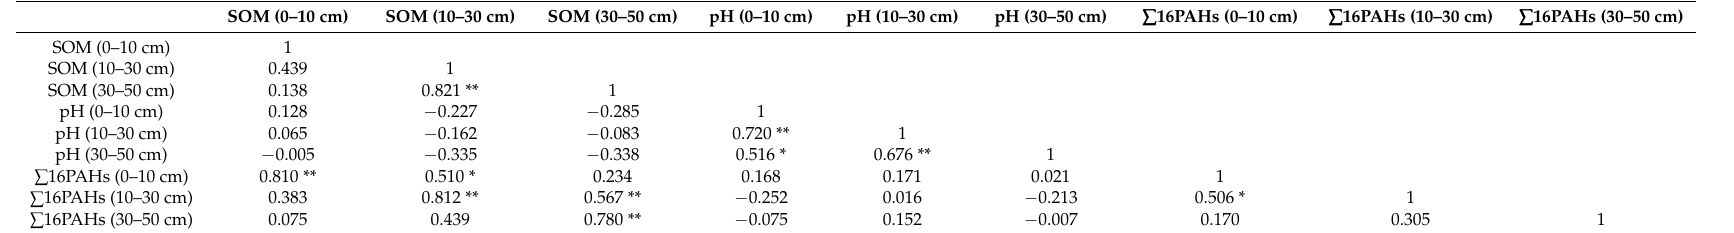
Table 4. Correlation analysis between ∑ 16PAHs, soil organic matter and